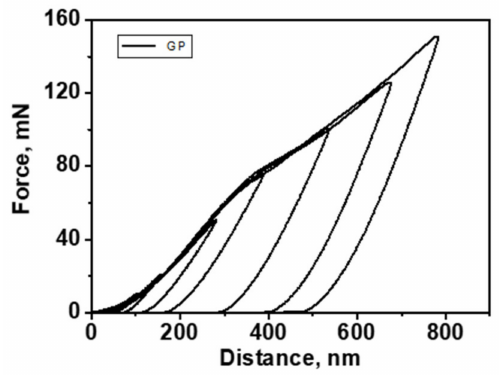
Figure 11. Load–discharge curve, resulting from a micro-hardness